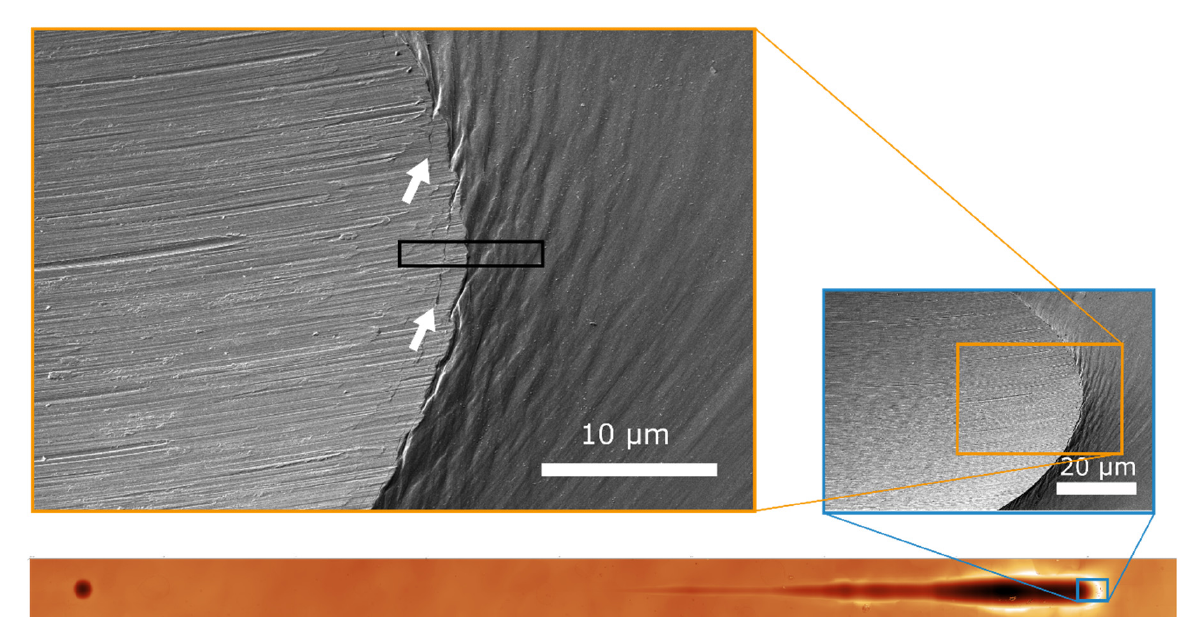
Figure 6. Topography of the end of the wear track in experiment 1. The white arrows highlight the dark line resulting from the compression of the folds by the ruby ball. The black rectangle indicates the position of the TEM foil shown in Figure 7. The foil was prepared parallel to the sliding direction.